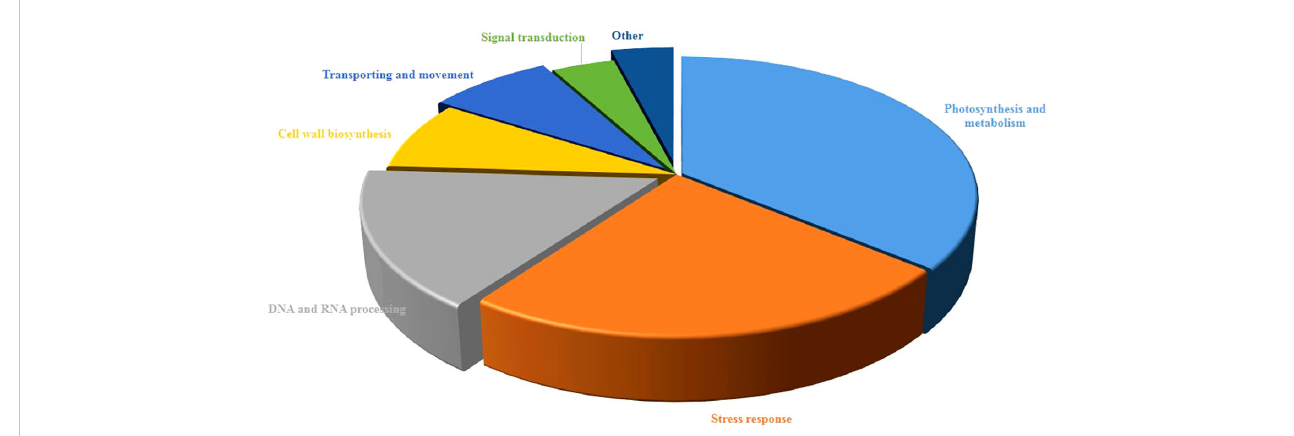
FIGURE 3 Functional classi fi cation of differentially regulated proteins of pistachio leaves under osmotic stress condition. The percentage of annotated proteins related to each pathway illustrated in pie